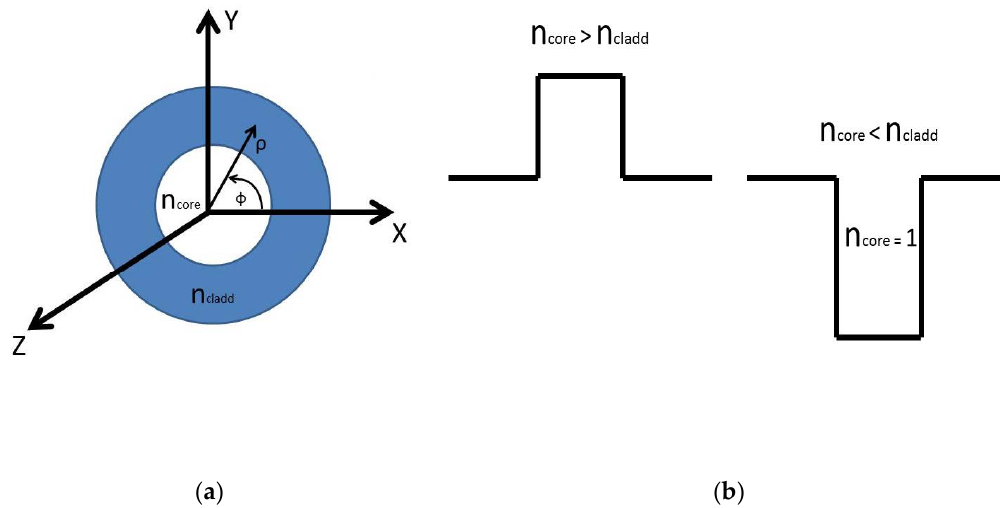
Figure 1. ( a ) Schematic representation of the cross section of a waveguide in a Cartesian and cylindrical coordinate system; ( b ) Schematic representation of the refractive index profiles for a waveguide that localizes radiation according to the principle of total internal reflection (step-index fiber) (left) and an air core waveguide with leaky modes (right).